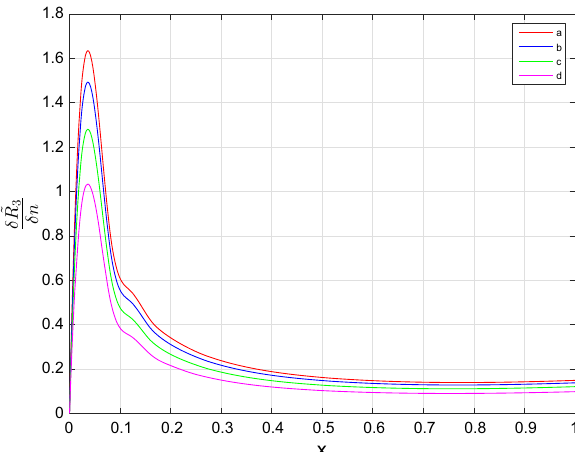
as a function of x for Fig. 7 Case 1: Perturbation through n , h , q . δ R 3 δ n n = 1 , α = 2 × 10 − 10 , α 1 = 0 . 2 , h = 0 . 5, red curve q = 100, blue curve q = 5000 , green curve q = 0 . 4 M (cid:7) , magenta curve q = 0 . 64 M